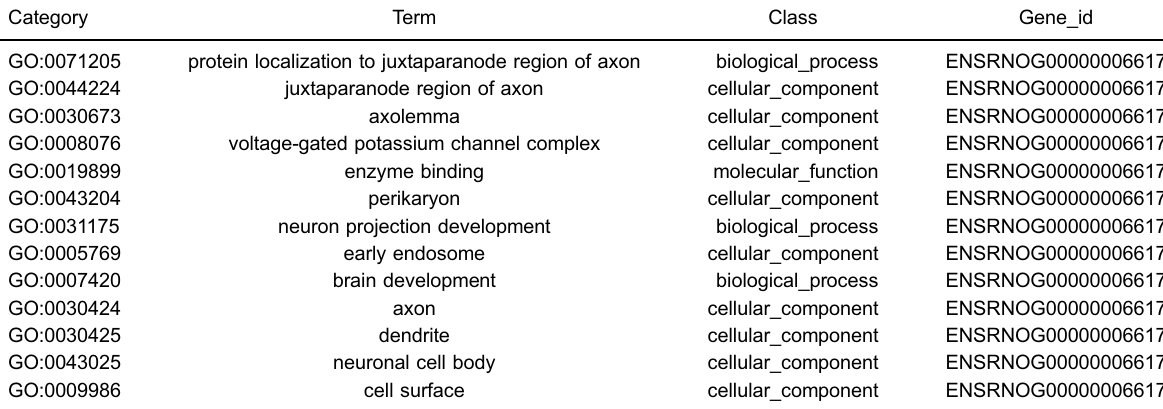
Table 6. Gene Ontology (GO) terms of rno-Cntnap2 long non-coding RNA gene.